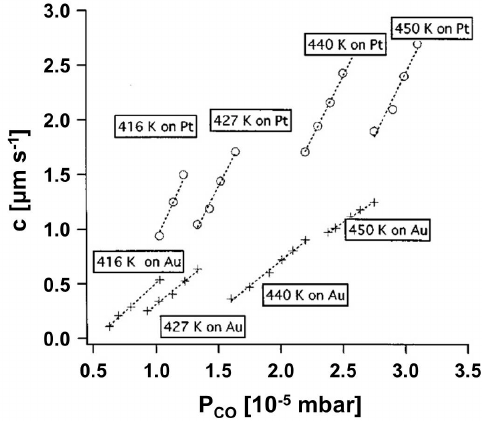
Figure 8. How the presence of Au atoms affects the kinetic parameters during CO oxidation on Pt: Propagation speeds for CO fronts on bare and 0.05 ML Au-covered Pt(110) as a function of CO pressure with a base oxygen pressure of P O = 4 × 10 − 2 Pa, at temperatures for conditions of dynamic bistability. This graph highlights the decrease of the CO diffusion coefficient due to the blocking effect of Au. Reprinted from [179], with the permission of AIP Publishing.